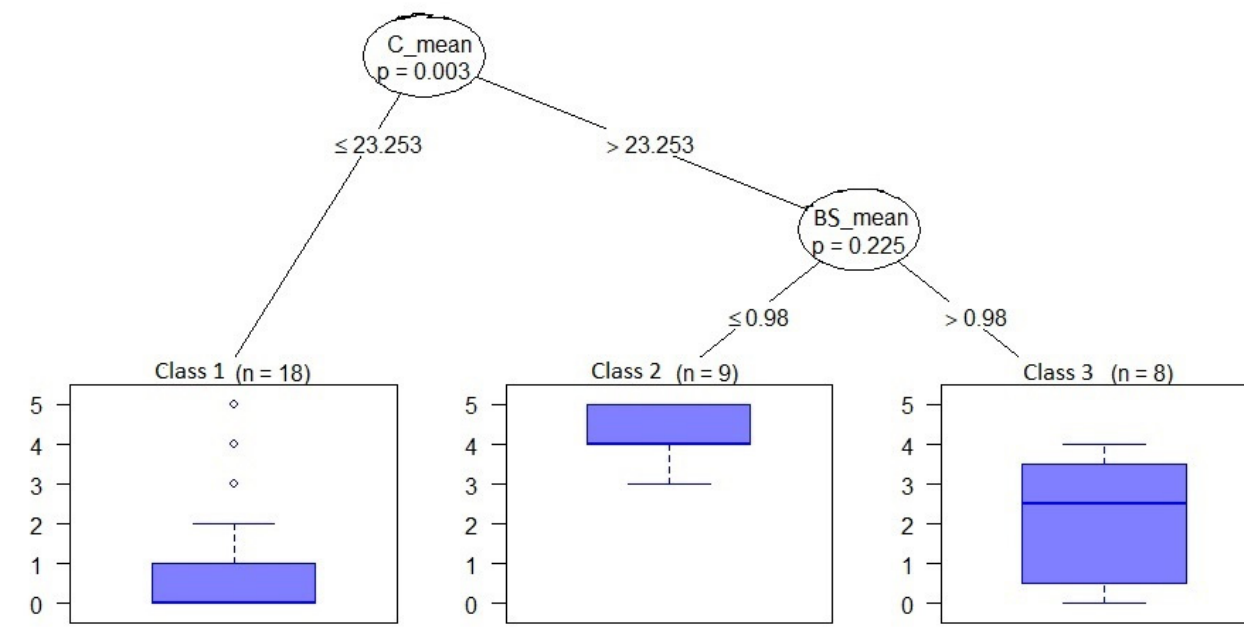
Figure 5. CART classification of health areas, according to the level of malaria risk and to cropland cover and bare soil cover. The blue box represents the number of times a health area was a hotspot. C_mean—mean cropland cover; BS_mean—mean bare soil cover.